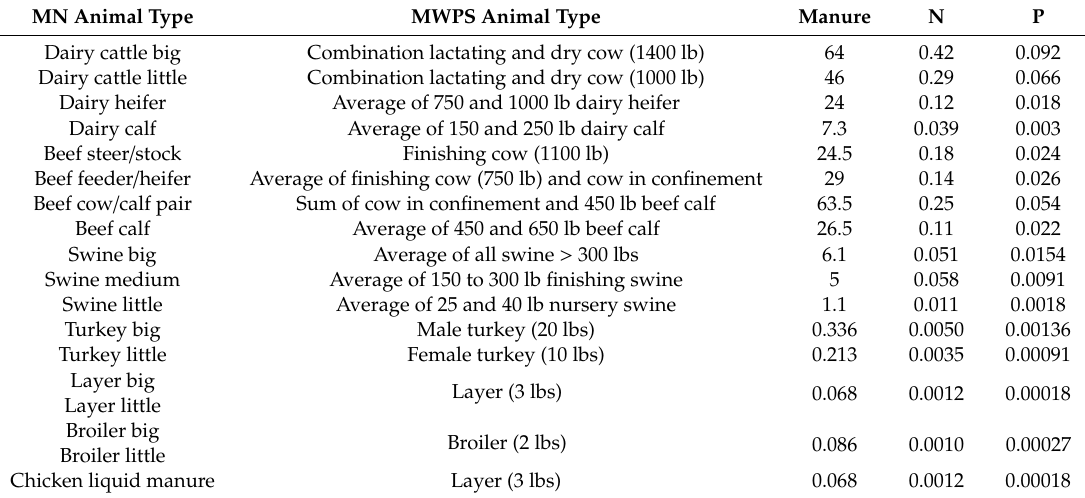
Table 3. Manure and Nutrient Excretion Values (in kg / head / day), as adapted from the Midwest Planning Service (MWPS)-18, 2004.